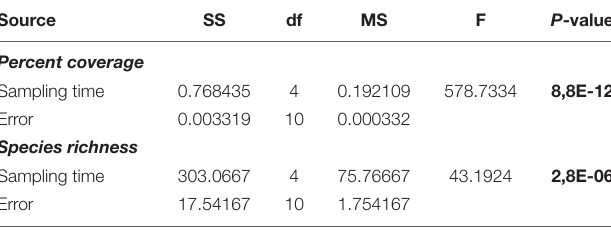
TABLE 1 | Results from one-way ANOVA test on percent coverage and species richness of vertical collectors.